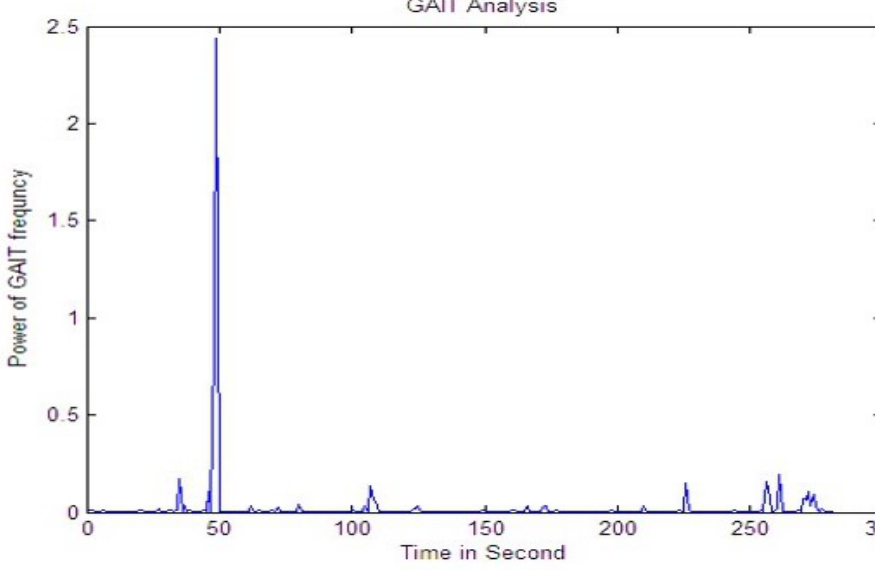
Figure 13. Signal while walking.